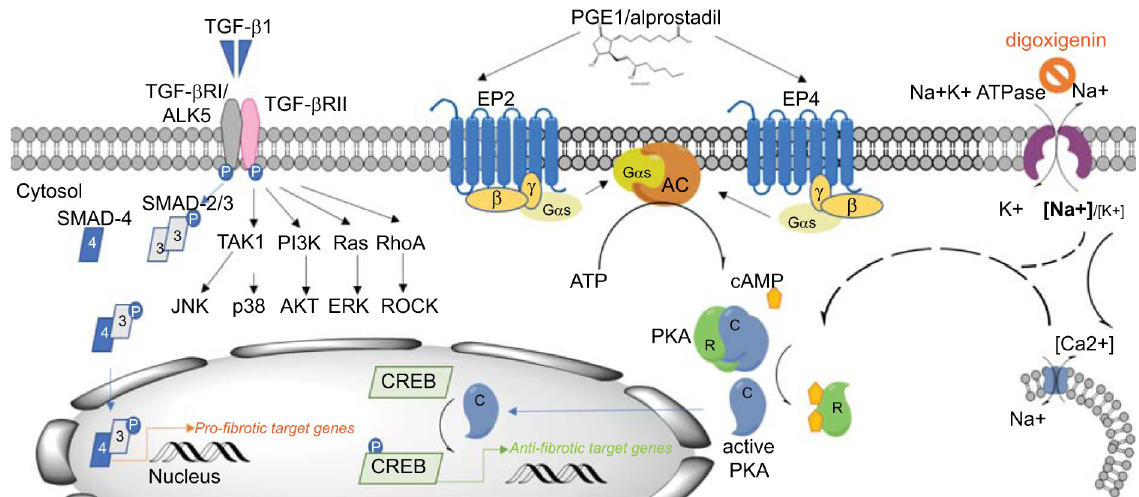
Fig 8. Summary binding of active TGF– β dimer to TGF– β receptor type II leads to the formation of a stable complex with the type I/ activin receptor–like kinase (ALK5) receptor and its transphosphorylation and activation. In the case of the canonical TGF– β signaling pathway, this results in the activation of SMAD family transcription factors SMAD–2 and –3 which, upon phosphorylation, form complexes with SMAD–4 and translocate to the nucleus, where they act in transcriptional complexes as regulators of pro–fibrotic down–stream genes [6]. In our assay, TGF– β 1 signaling involved ALK5 and SMAD3, but also all three mitogen–activated protein kinase (MAPK) pathways: e,g, the extracellular signal–regulated kinase (ERK), p38 MAPK, and c–Jun–N–terminal kinase (JNK) pathways. In addition, TGF– β 1 effect was mediated by PI3 kinase / Akt and Rho GTPase pathways. Binding of alprostadil to the G–protein coupled receptors EP 2 and EP 4 , which are linked to G– α s proteins, induced the adenylate cyclase–mediated cAMP second messenger formation from ATP. It is well established that cAMP acts by activating protein kinase A (PKA) [28, 29], resulting in dissociation of the regulatory (R) and the catalytic (C) subunits of the kinase. The catalytic subunits translocate to the nucleus and initiate the activation of the cAMP response element binding (CREB) transcription factor, and, as a consequence, transcription of downstream genes. Cardiac glycosides concentration–dependently increased the intracellular [Na + ] i /[K + ] i ratio, which led to an increase in COX2 expression and PKA activation and decreased α –SMA, COL1 and FN [30]. To which extent this effect was mediated by an increase in intracellular Ca 2+ concentration through activation of the reverse mode of an Na + / Ca 2+ exchanger warrants further